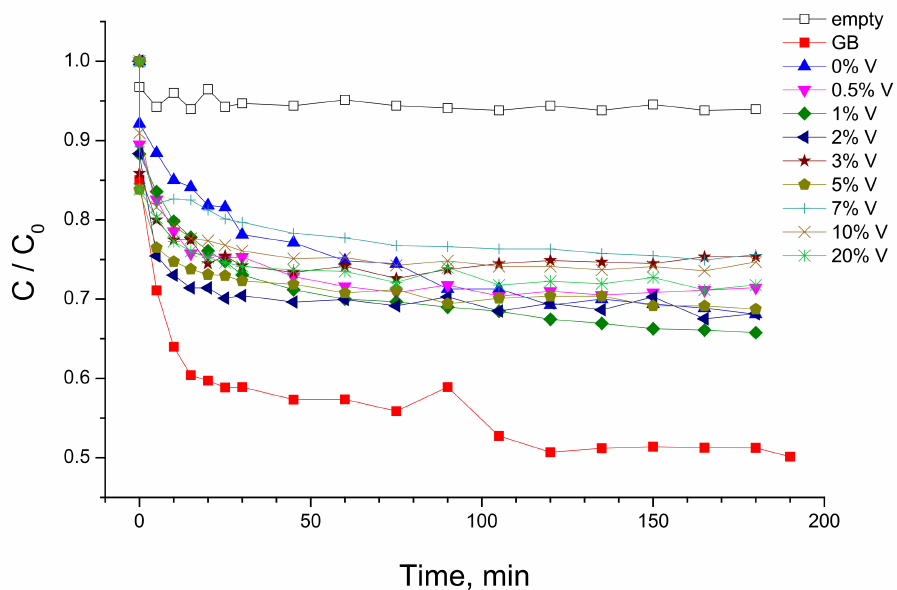
Figure 7. MB adsorption measurements with UVA lamp “off” using uncoated and V-TiO 2 coated glass beads (GB). Adsorption curve in empty reactor is also shown. Vanadium content is indicated in